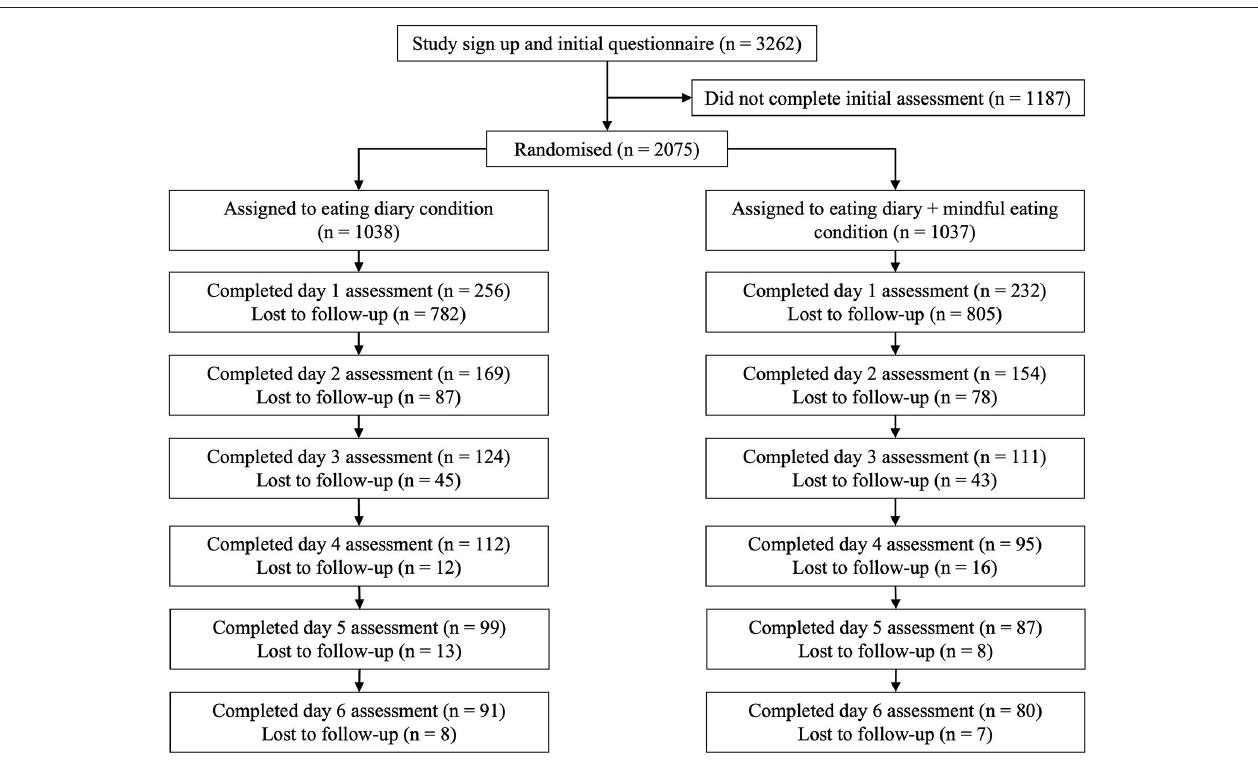
FIGURE 1 | Flow diagram representing participants’ attrition from the survey and follow-up